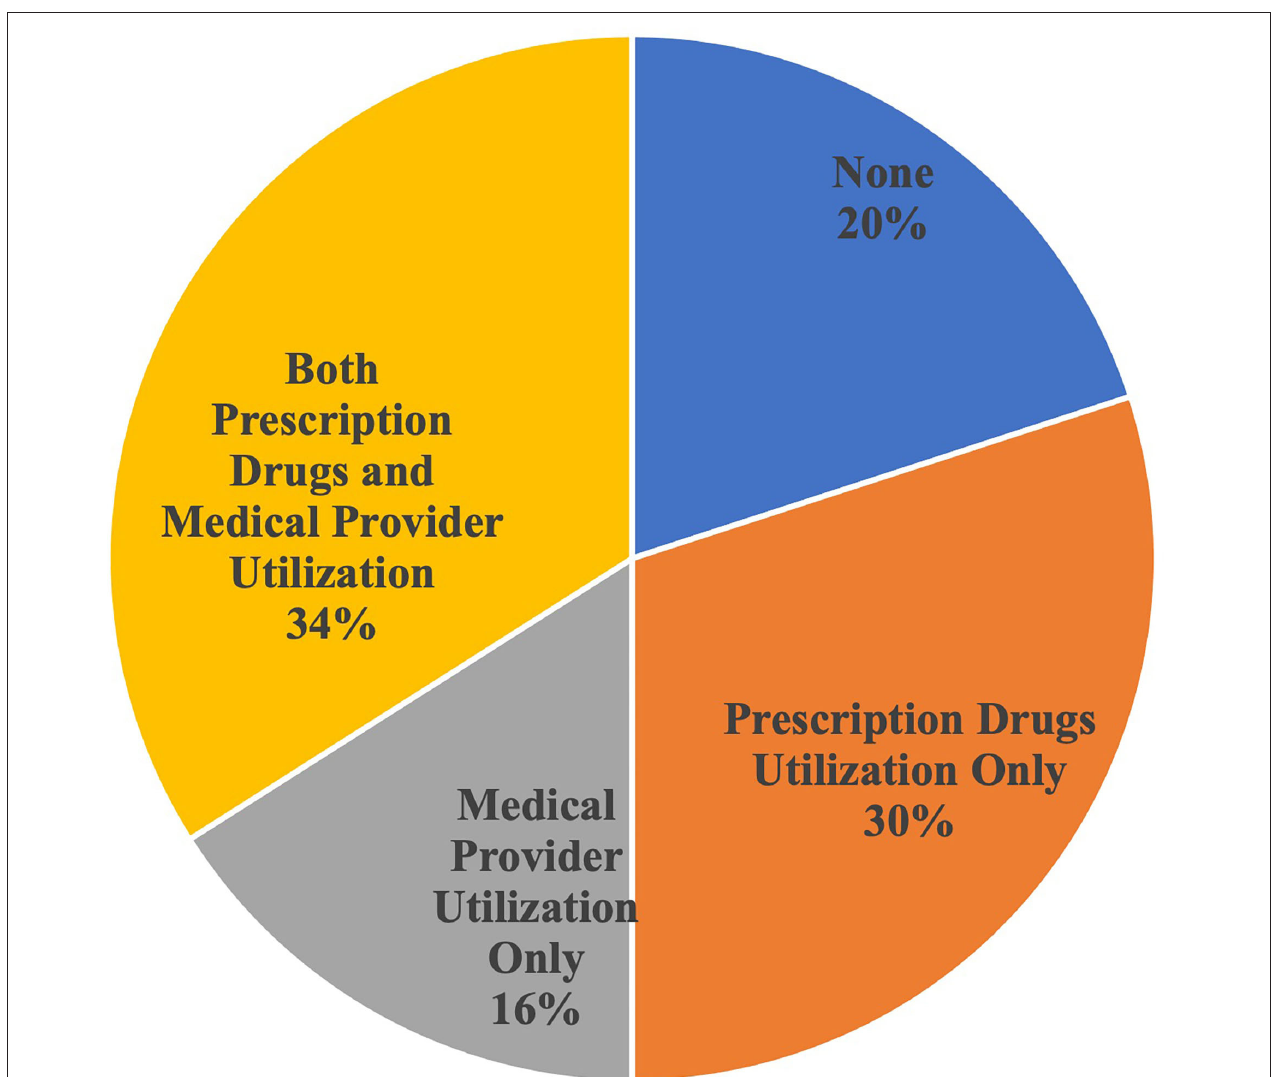
FIGURE 2 | Intersection of medical provider and prescription drug utilization by Medicare beneficiaries with untreated functional hearing trouble. Source: Authors’ analysis of the Medicare Current Beneficiary Survey 2017. Medical provider includes medical doctor, nurse practitioner, physician assistant, and nurses. Prescription drugs do not include beneficiaries who report often receiving their prescription drugs in the mail or through the